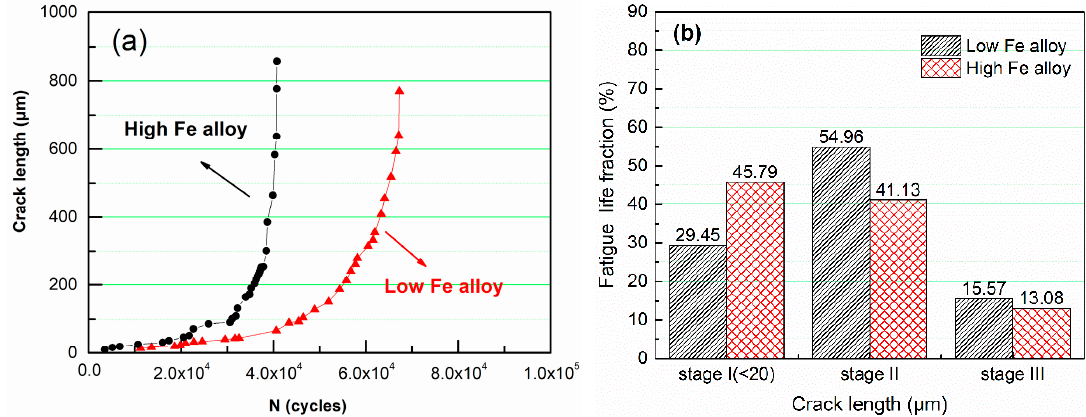
Figure 10. ( a ) Fatigue crack length versus the number of load cycles for High Fe alloy and Low Fe alloys, ( b ) in-situ fatigue life fraction of High Fe alloy and Low Fe alloy at different stages.